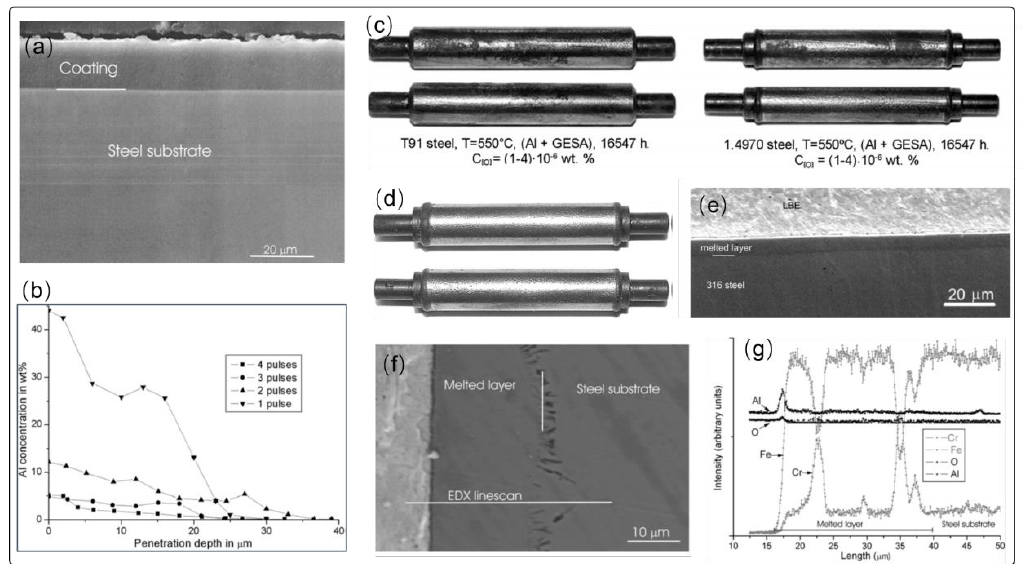
Figure 4. Al-containing coating prepared via GESA ( a ) and melting depth dependence of Al content under different number of pulse with energy density of electron beam 45 J/cm 2 ( b ), ( c ) Al-containing coating prepared via GESA process after corrosion test, ( d ) Fe78Cr14Al8 coating prepared by GESA, ( e ) corrosion morphology of Al-containing coatings treated by GESA exposure to LBE, ( f ) corrosion morphology of Al-containing coating after LBE corrosion and corresponding EDS element distribution ( g ) [57]. Figure 4 is reprinted with permission from ref [57]. Copyright 2011 Elsevier.